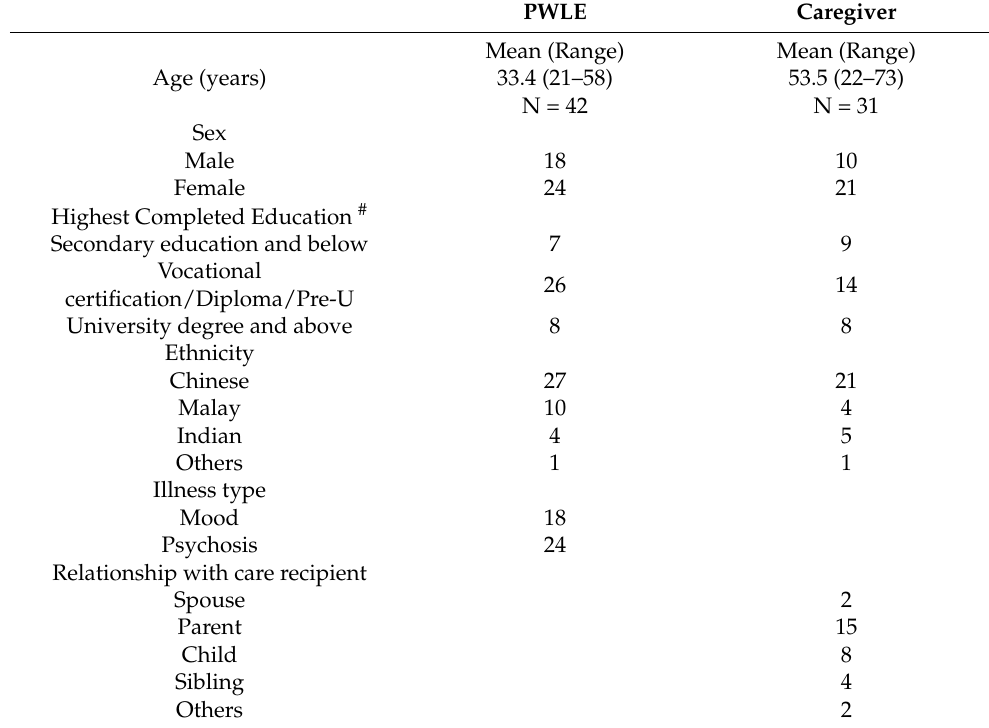
Table 1. Sociodemographic